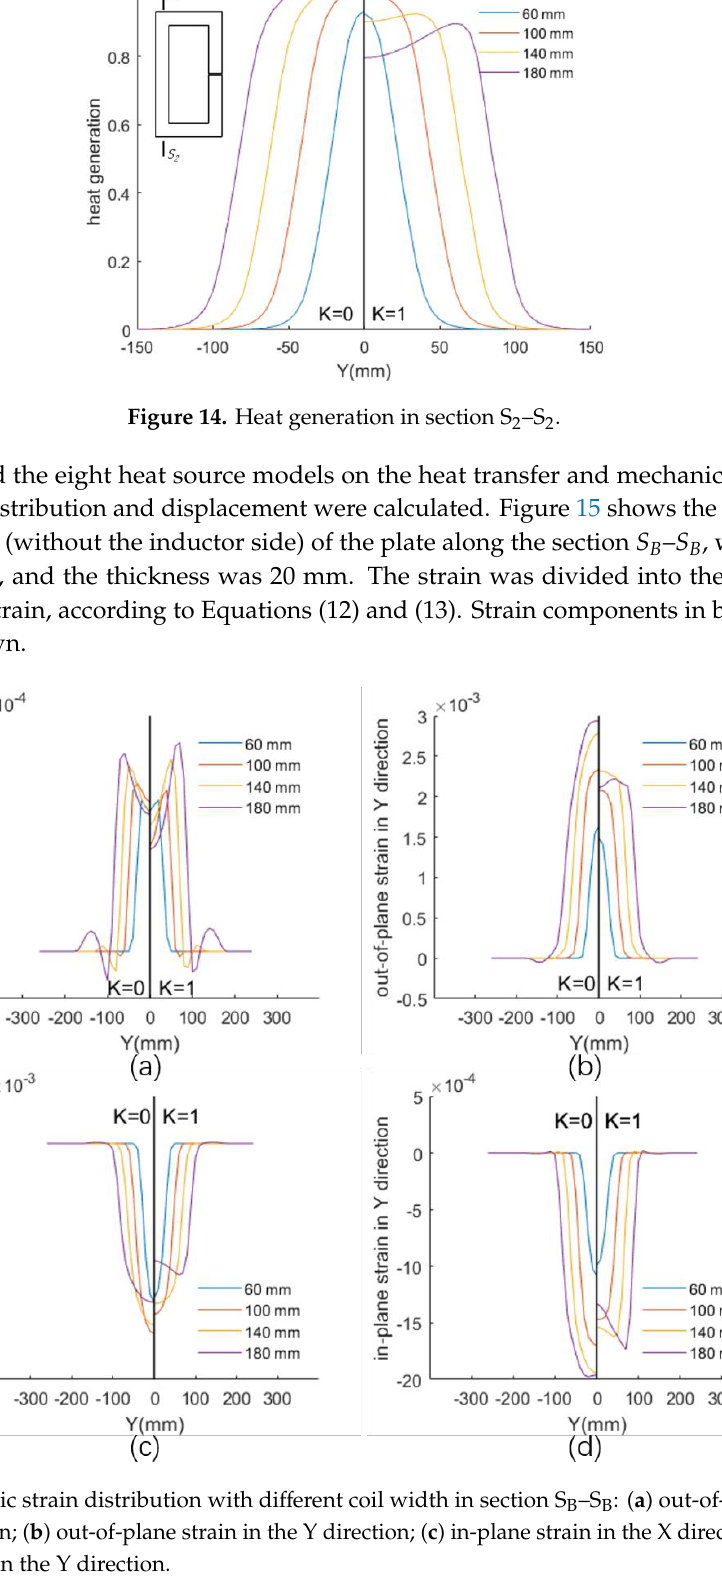
Figure 13. Heat source distribution comparison.